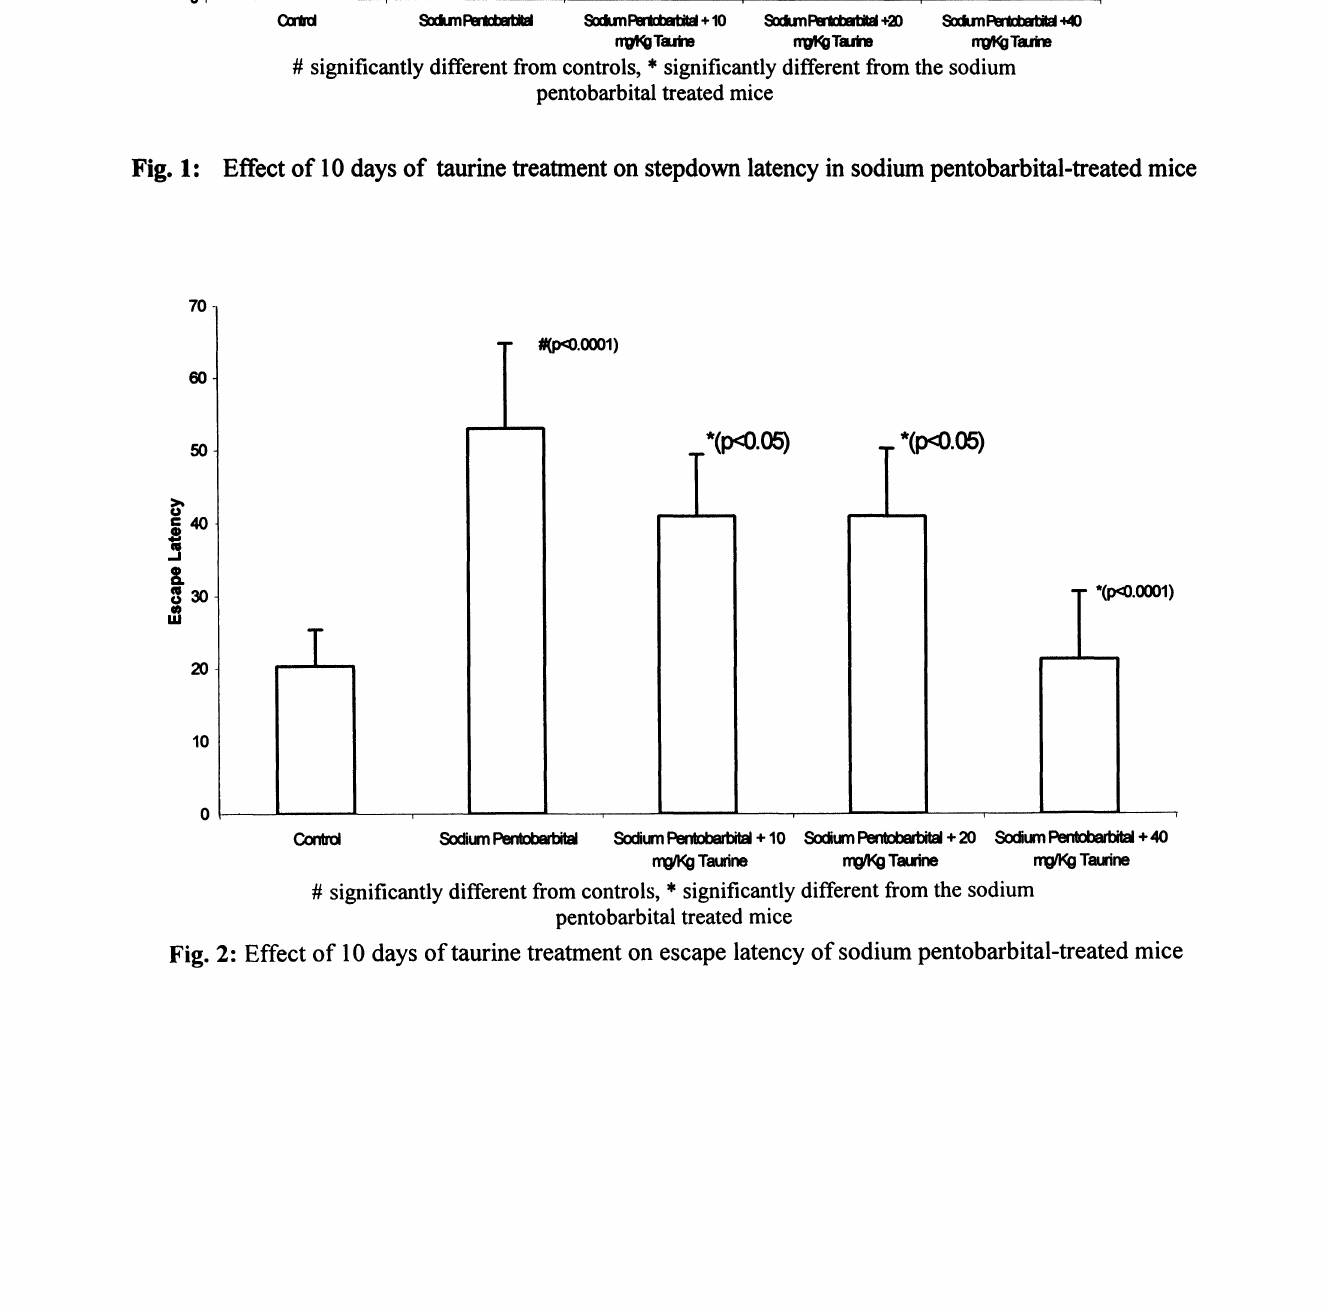
Fig. 2: Effect of 10 days of taurine treatment on escape latency of sodium pentobarbital-treated